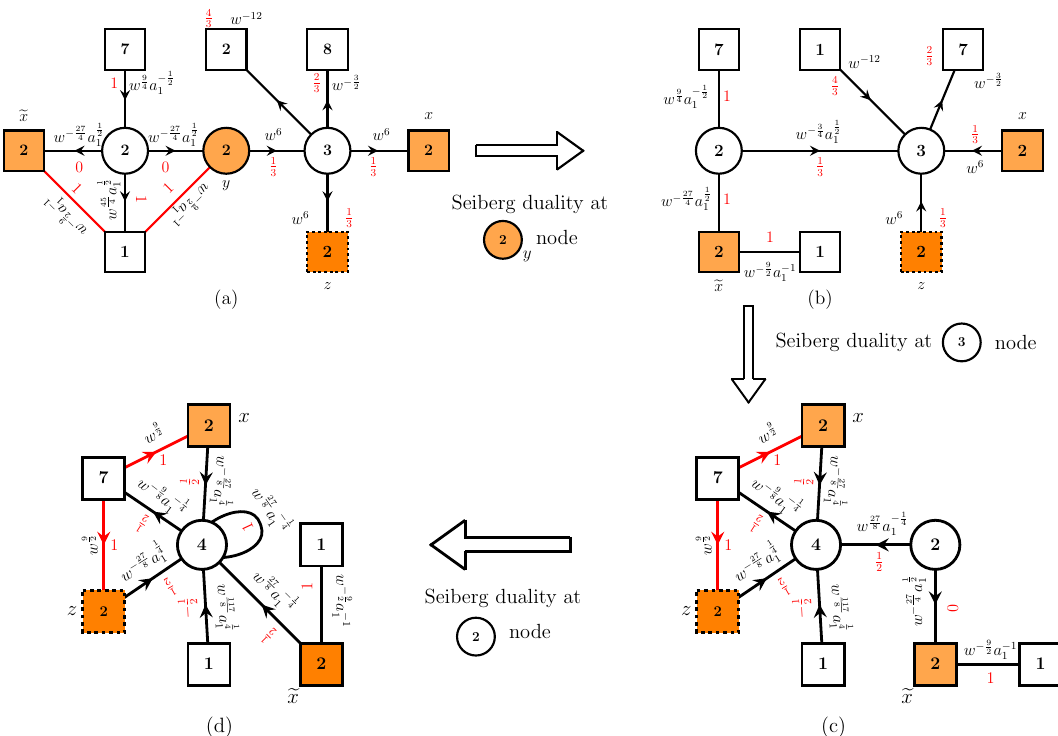
1 minimal puncture with z node. Resulting y